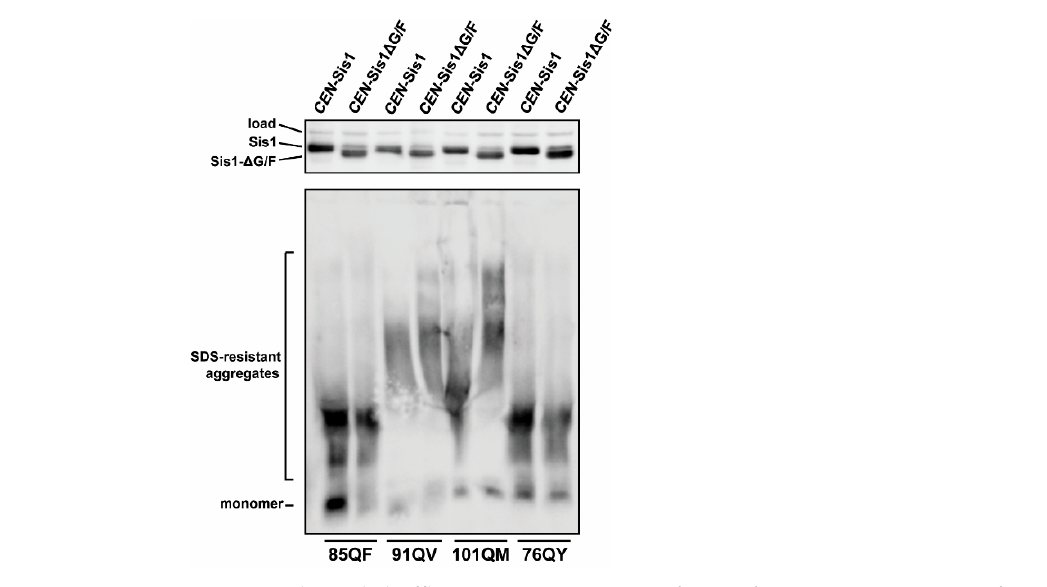
Figure 4. Plasmid shuffling experiments to test for a G/F region requirement of Sis1 by polyQX synthetic prions. PolyQX prion-bearing cells were transformed by plasmids expressing Sis1 or an internal deletion (Sis1 Δ G/F) and subjected to plasmid shuffling. Cell lysates were prepared from sis1 - Δ cells expressing either wild-type Sis1 or Sis1 Δ G/F from a plasmid and were subjected to SDS-PAGE ( top panel ) and SDD-AGE ( bottom panel ) followed by immunoblot analysis with Sis1 and Sup35 antibodies. A band cross-reacting with the Sis1 antibody is shown as a loading control. In this case, only one shuffling attempt was successful for each construct.